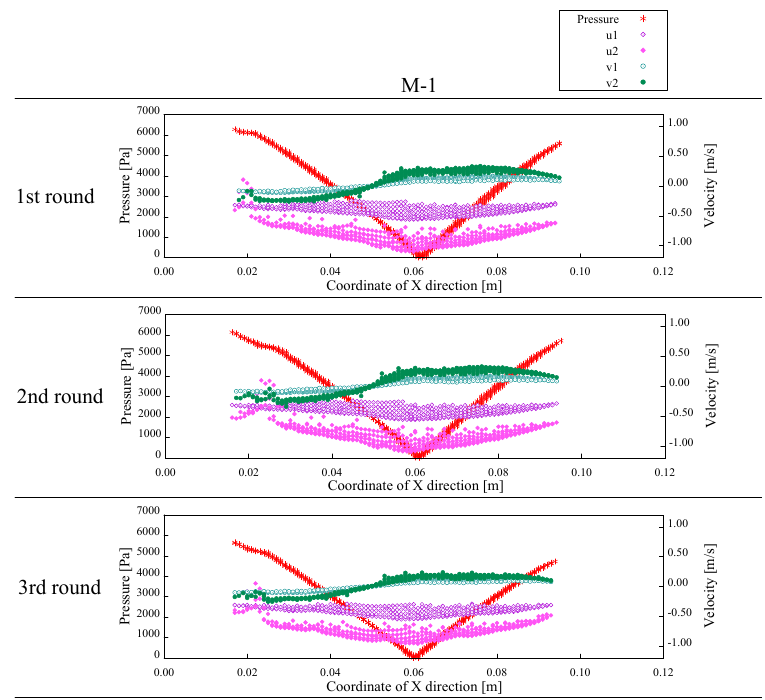
Figure 23. Comparison of the values of the pressure and flow velocity from the simulation results of M-1.